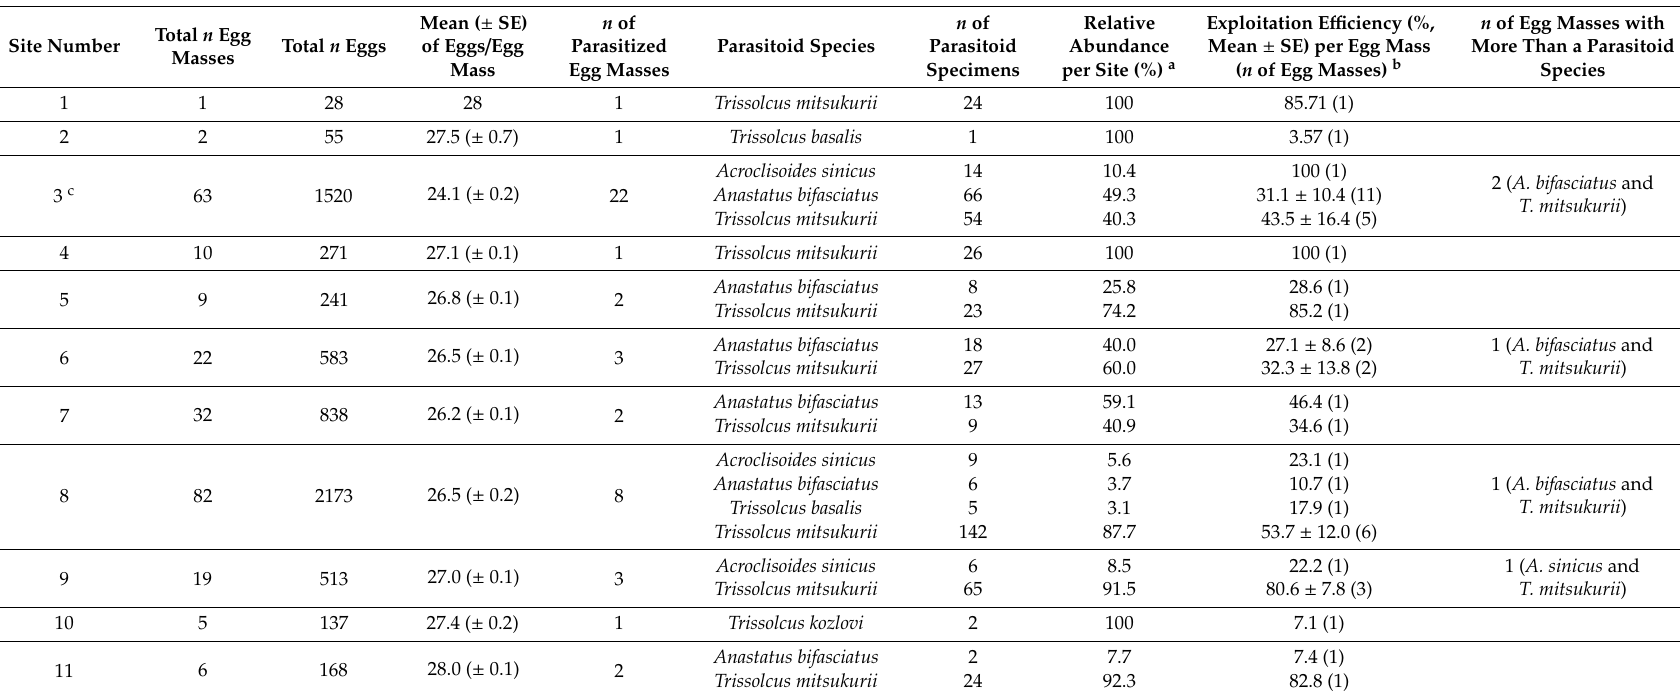
Table 2. Identity and abundance of Halyomorpha halys parasitoids and hyperparasitoids emerged from collected egg masses per